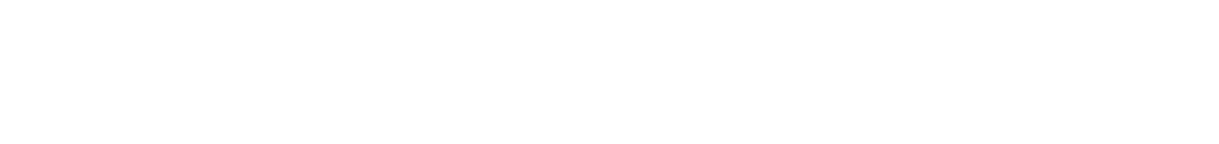
Frontiers in Bioengineering and Biotechnology |